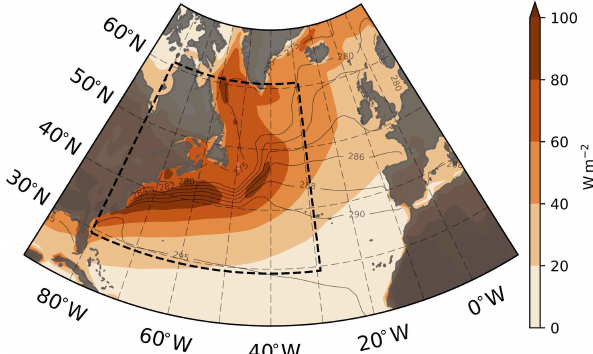
Figure 1. Temporal standard deviation of F (shading) and SST winter climatology (contours, every 2K from 280 to 290K, ev- ery 5K otherwise). The area within the dashed box (30–60 ◦ N, 30– 79.5 ◦ W) corresponds to the region of the North Atlantic considered in the next sections for the computation of spatial